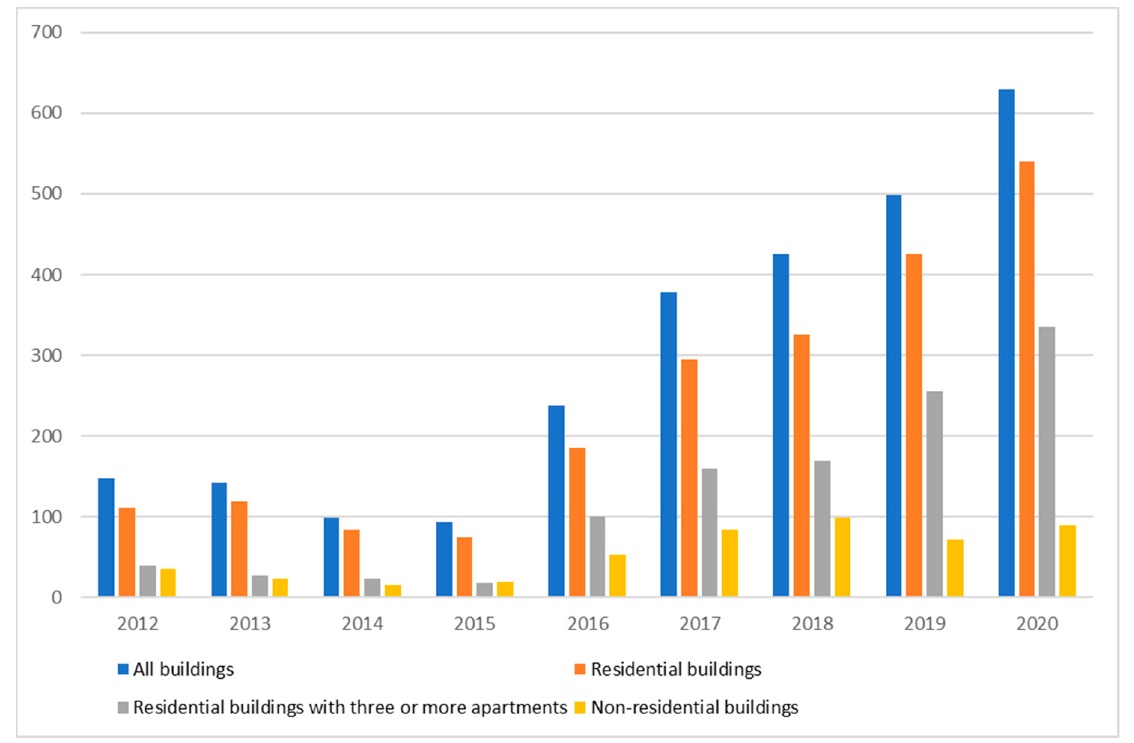
Figure 1. Number of issued construction permits.